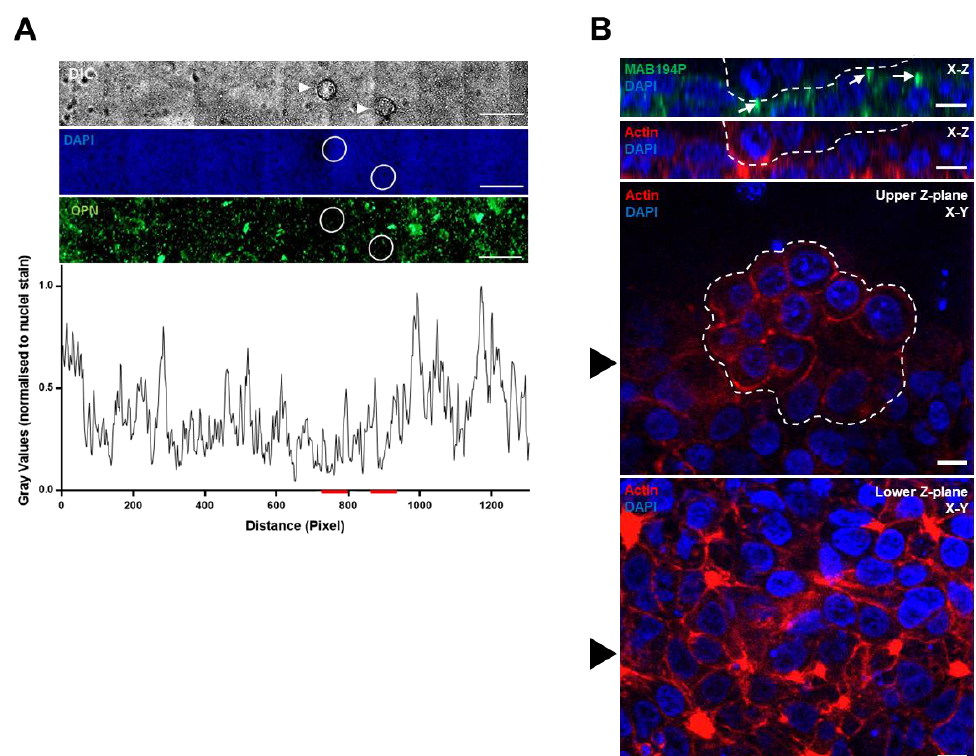
Figure 3. ( A ) Mouse blastocysts were cultured with Ishikawa cell layers for the apposition phase of implantation in vitro (E4.5 – 5.5). Unattached or weakly attached blastocysts (white arrowheads in top panel) were washed off the Ishkikawa cells before immunostaining with MAB194P. The sites of embryo apposition were identified (white circles). Scale bars are 500 µm. MAB194P intensity normalised to DAPI intensity was measured across the sample and plotted as a line-graph, red lines indicate embryo positions (lower panel). ( B ) Mouse blastocysts stably attached to Ishikawa cells were co-immunostained with MAB194P (green) and phalloidin to label filamentous actin (red). Ten optical sections were captured at 2 µm intervals. Upper panels show Z-plane stacks of optical sections, with white arrows highlighting MAB194P-positive structures. Embryonic cells are delineated by a dashed white line. Lower panels of individual optical sections show subjacent Ishikawa cells and attached embryo. Black arrowhead in lower panels indicates the slice of the Z-plane stacks. Scale bars are 10 µm.